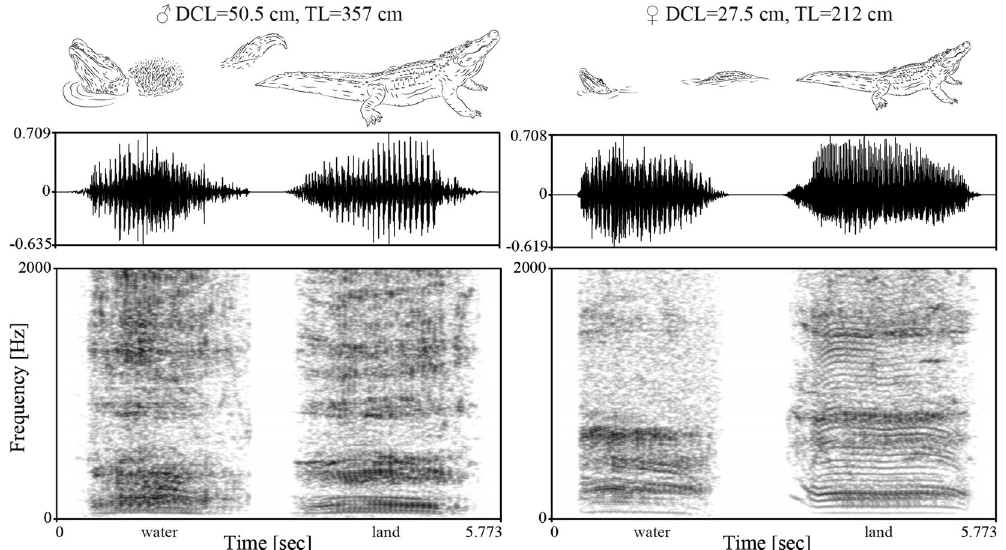
Figure 2. Example recordings of bellows by a male and a female American alligator in water and on land (Peak amplitude equalized to − 3 dB in Adobe Audition, Spectrogram settings in Praat: Window length [sec]: 0.12; Dynamic range [rel dB]: 40.0, drawings by